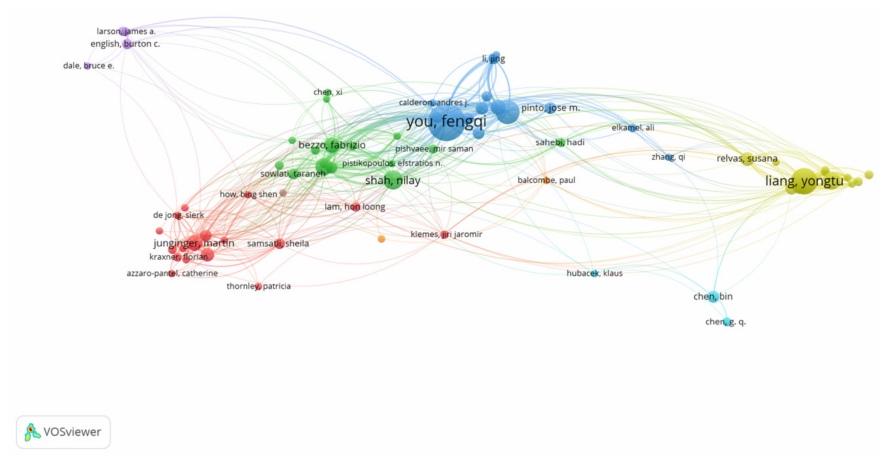
Figure 8. Citation map of the